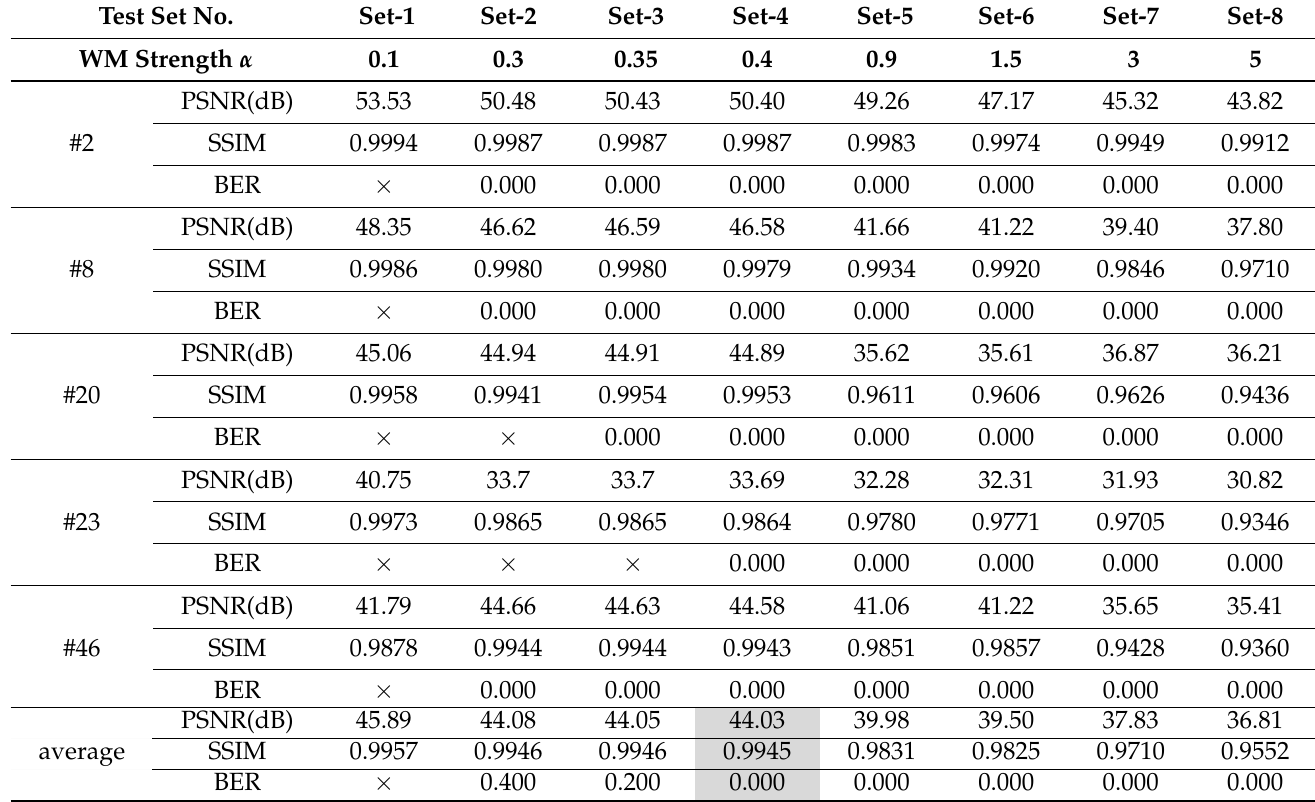
Table 2. Evaluation result for various scale factor α .